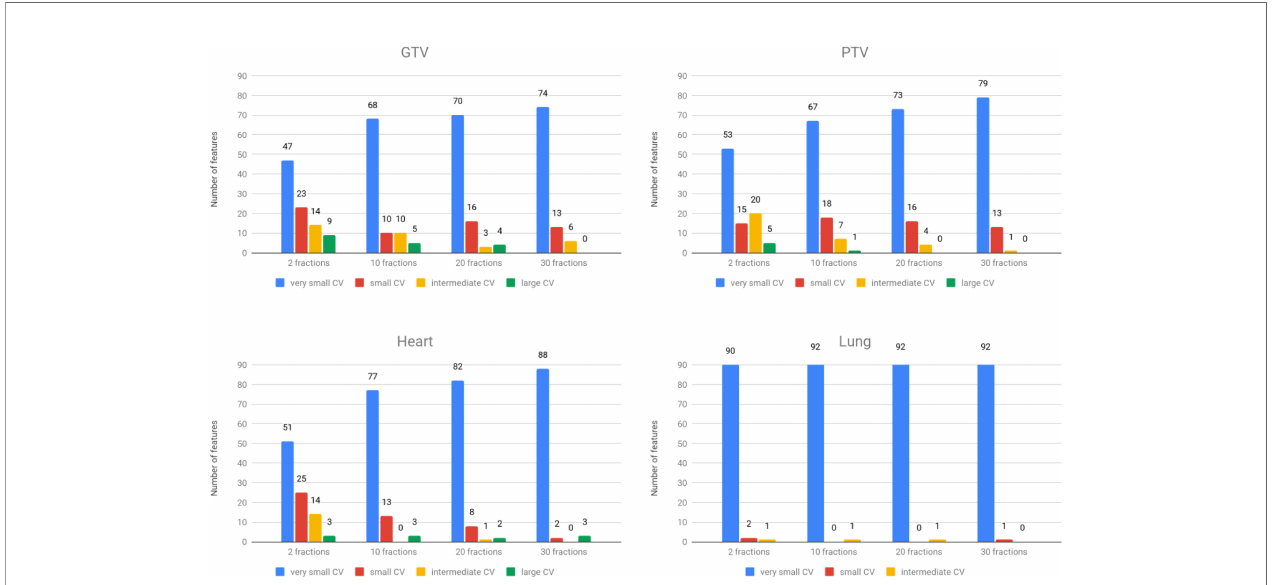
FIGURE 4 | The number of features was categorized into four groups based on CVs. Top left: GTV region. Top right: PTV region. Bottom left: heart region. Bottom right: lung